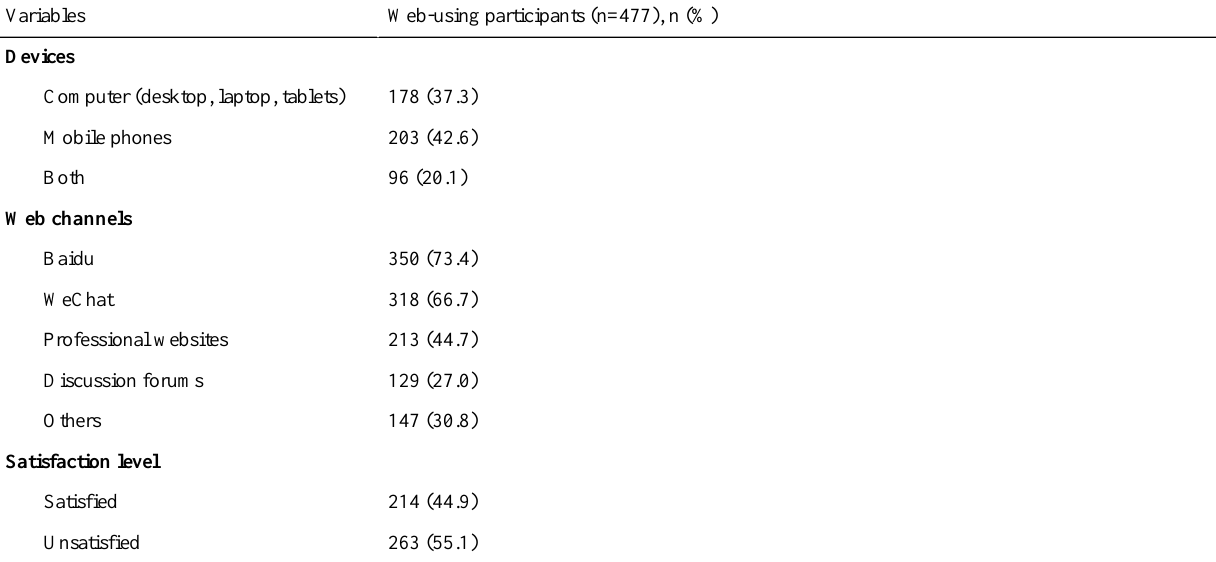
Table 3. Details of patients’web-based breast cancer information-searching behavior.